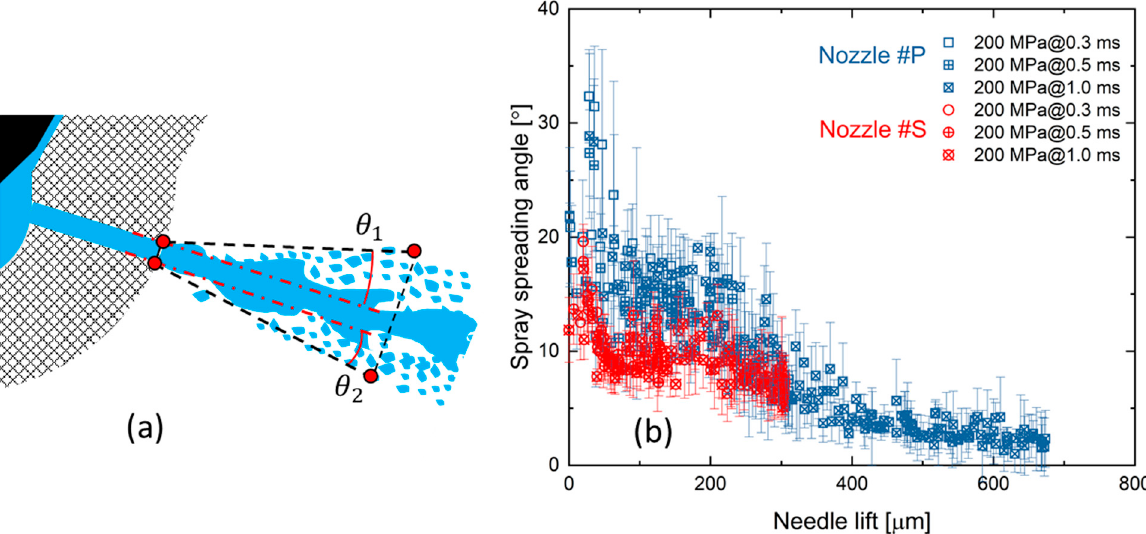
Figure 7. Comparison of the spray spreading angle between two nozzles: ( a ) the definition of spray spreading angle; ( b ) the results of spray spreading angle.